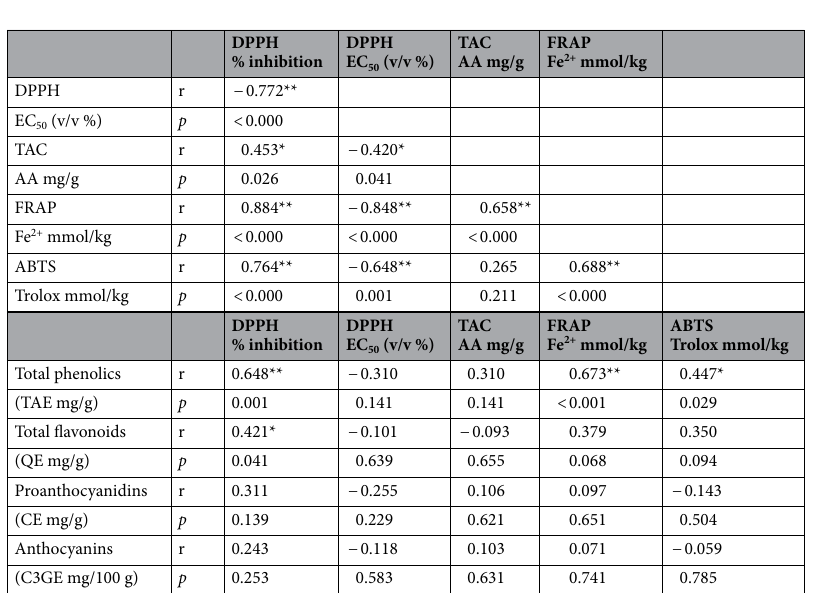
Table 3. Pearson’s correlation coefficients (r) and the corresponding p values for different antioxidative capacity assays and the Pearson’s correlation between the phenolics content and the antioxidant assays data (N = 24). *Correlation is significant at the 0.01 level (2-tailed). **Correlation is significant at the 0.05 level (2-tailed); “r-Pearson’s coefficient of correlation, p